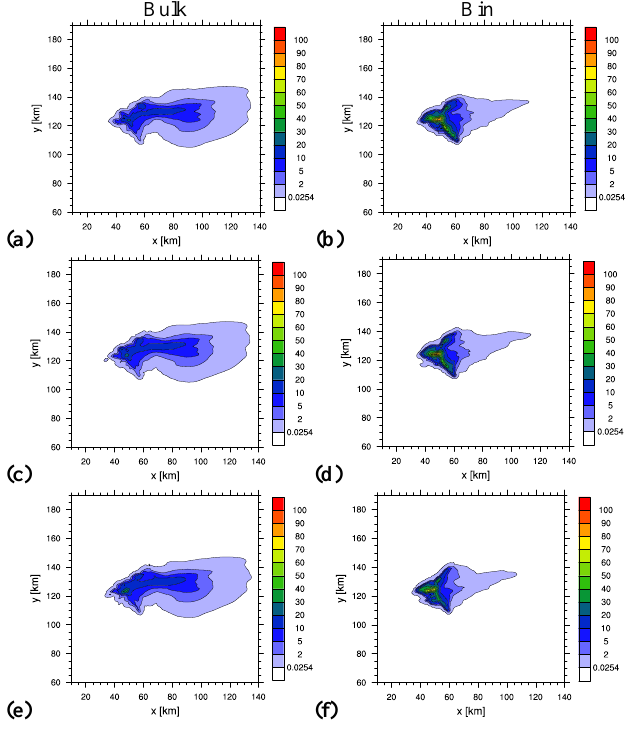
Fig. 10. As in Fig. 4 except for the low relative humidity